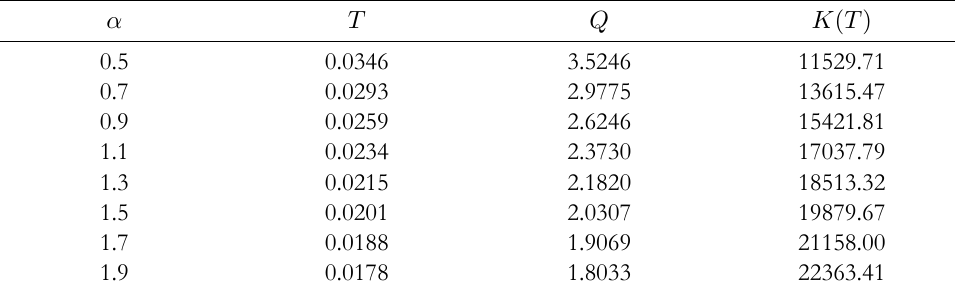
Table 6: Variation in T; Q & K ( T ) with holding coefficient ( (cid:11) )